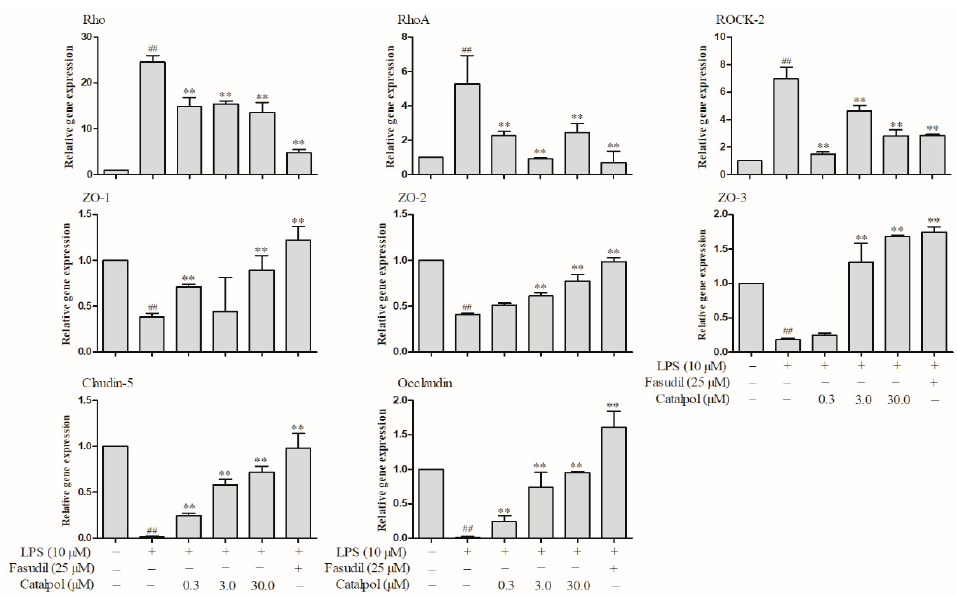
Figure 9. The effects of catalpol on the changes of tight junction and Rho/ROCK pathway mRNA level induced by LPS detected by qPCR ( ± SD, n = 3). ## p < 0.01 vs. the control group; ** p < 0.01, vs. the LPS